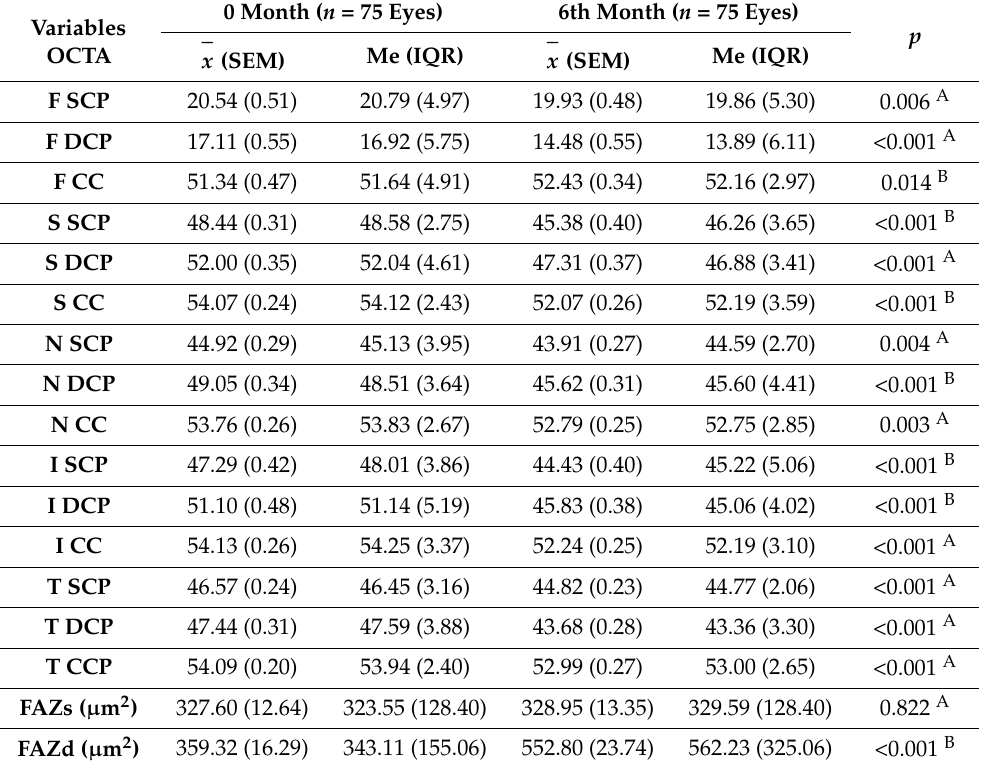
Table 3. Comparison of foveal (F) and parafoveal parameters of OCTA (optical coherence tomog- raphy angiography) between 0 months and the 6th month in all COVID-19 patients (women